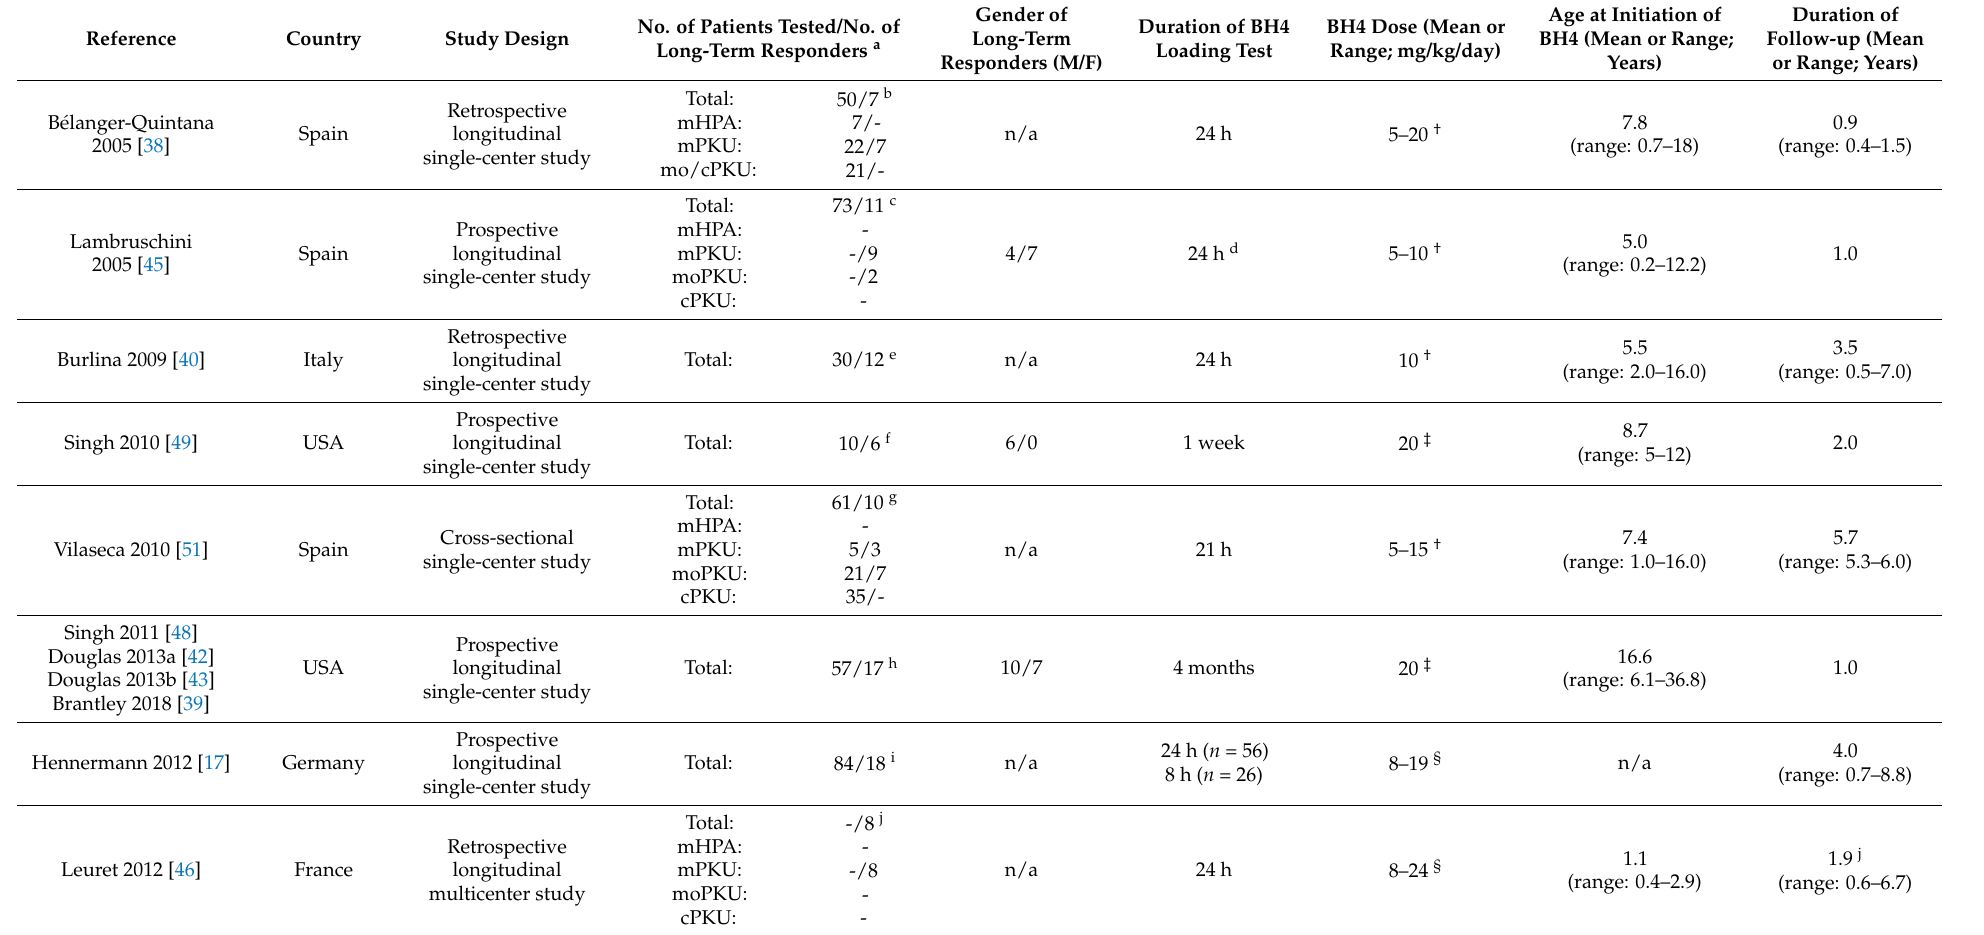
Table 1. Main characteristics of included